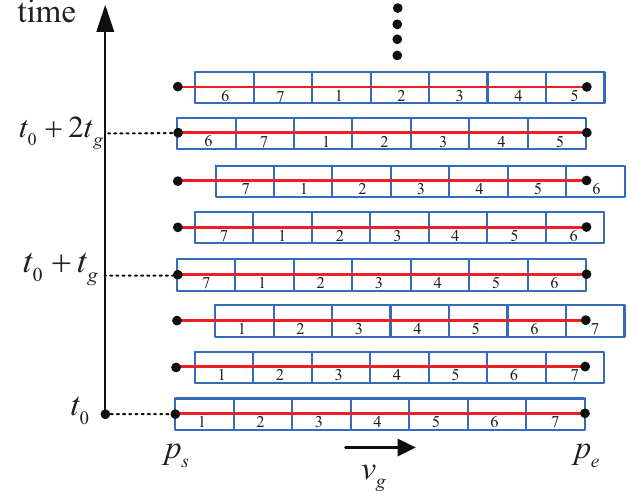
Figure 7. Concept and motion of virtual